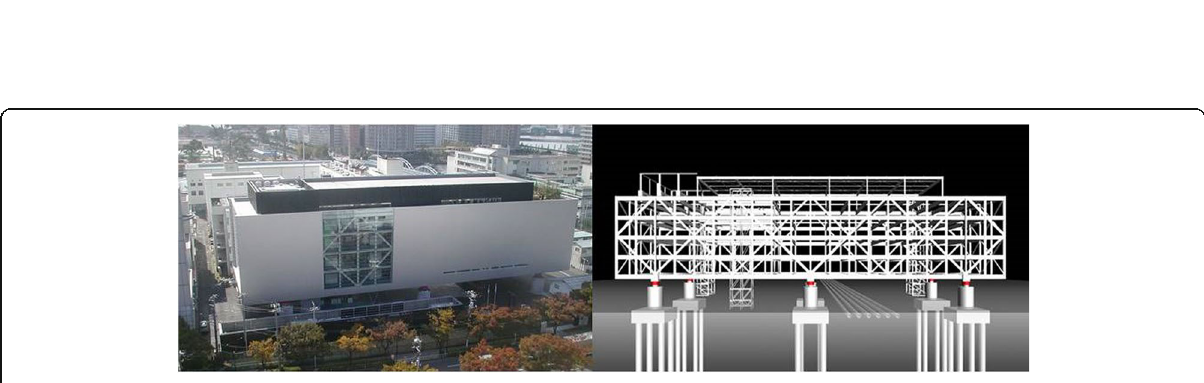
Fig. 8 Variations of seismic isolation method